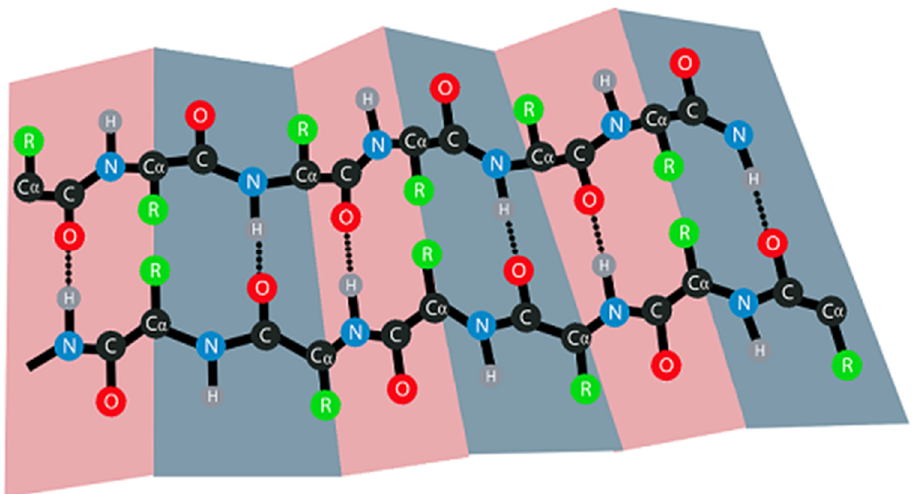
Figure 6. Scheme of the folding in a parallel β -sheet. The folded “paper” planes in the model are created by creases (marked in pink and grey), that are defined by the bonds between the C α atoms of the two β -strands (marked in black structure).